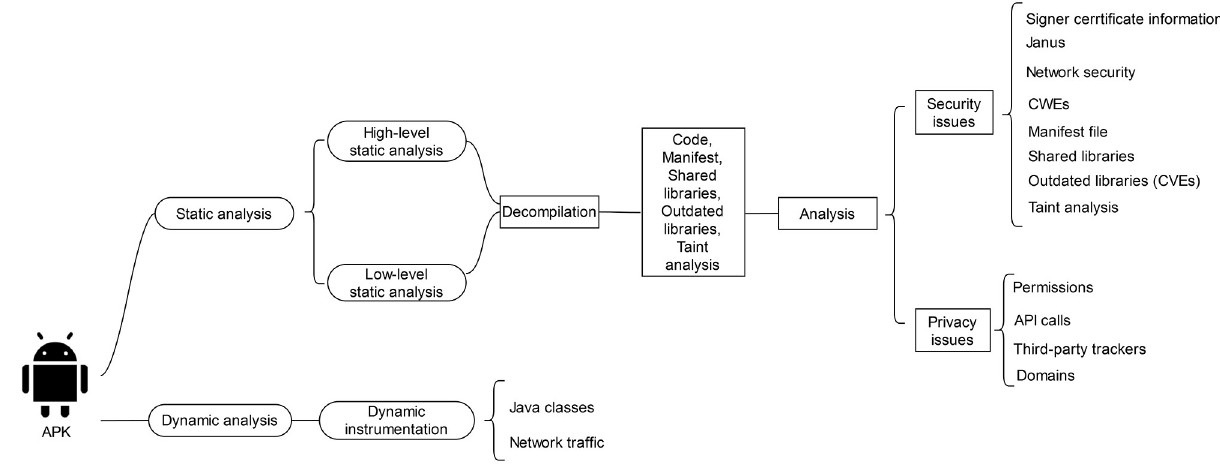
Fig 1. Overview of the followed